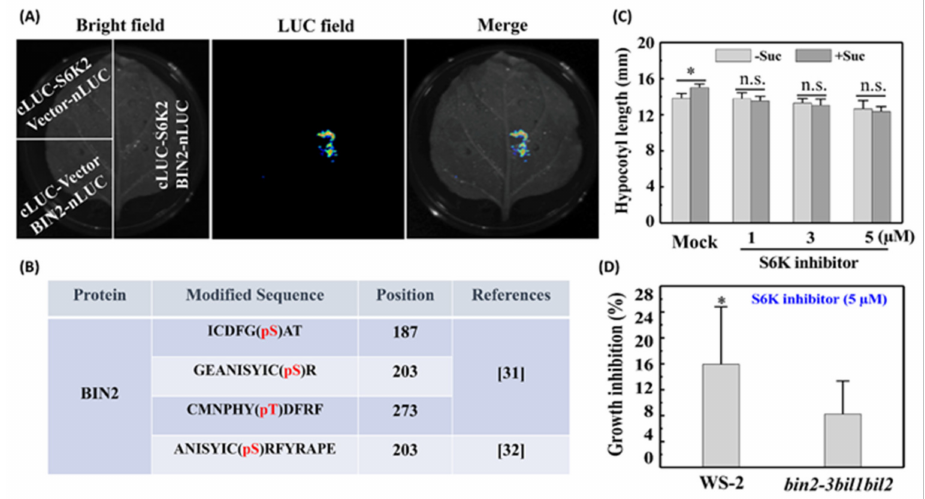
Figure 5. Roles of S6K2 in skotomorphogenesis. ( A ) Interaction between S6K2 and BIN2. The interaction was determined using a split-luciferase complementation assay in Nicotiana benthamiana . The full-length coding sequences of S6K2 and BIN2 were ligated into the pCAMBIA-35S-NLuc and pCAMBIA-35S-CLuc vectors, respectively. The empty vectors were used as negative controls. ( B ) In vitro phosphorylation sites of BIN2 catalyzed by S6K2 was identified by in vitro kinase assay followed by mass spectrometric analysis [31], of which S203 was found to be an in vivo phosphoryla- tion site based on proteomics analyses [32] (http://epsd.biocuckoo.cn/ accessed on 21 May 2021). ( C ) Hypocotyl length of wild-type (WT) etiolated seedlings treated with different concentrations of S6K inhibitor (LY2584702 tosylate). ( D ) Growth inhibition of Ws-2 and bin2-3bil1bil2 mutant induced by S6K inhibitor. Growth inhibition (%) = (1 − L t / L n ). L t and L n represent the hypocotyl length of etiolated seedlings grown in medium with or without the S6K inhibitor, respectively. Error bars represent the standard deviations (SD) ( n > 20). Data were statistically evaluated using Student’s t -test, and the significance of differences (*, p < 0.05; n.s., not significant) is